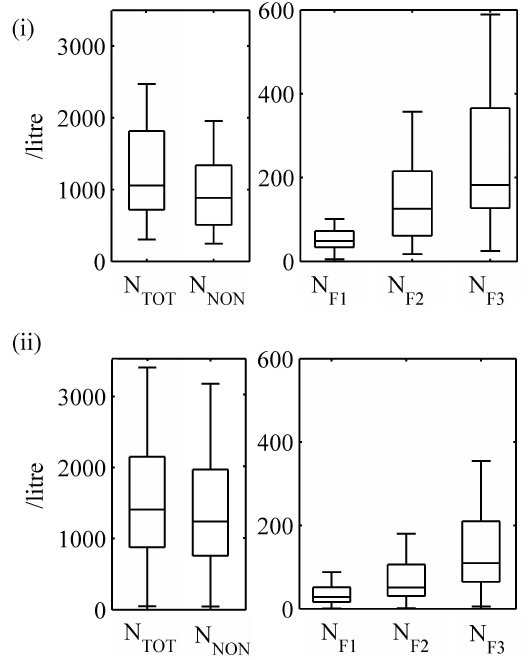
Fig. 2. Box-and-whisker plots of N NON , N TOT and fluorescent number concentrations in Manchester during (i) filter sampling pe- riods and (ii) for the overall dataset.